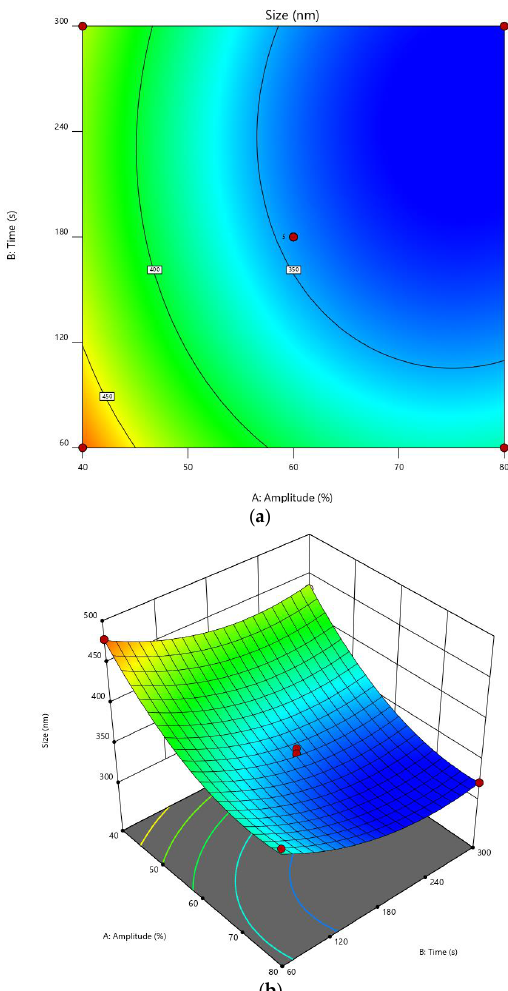
Figure 3. Contour plot ( a ) and 3D response surface ( b ). Blue, light blue, green, yellow, and red colors were 321, 350, 400, 450, and 493 nm, respectively. Table 3. Variable levels and responses of particle sizes based on amplitude and time. Exp. Order